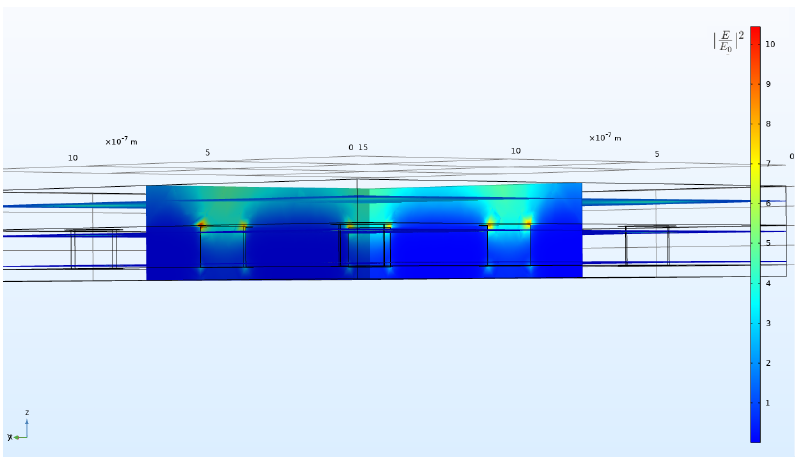
Figure 2. Observation of the generation and propagation of surface plasmon